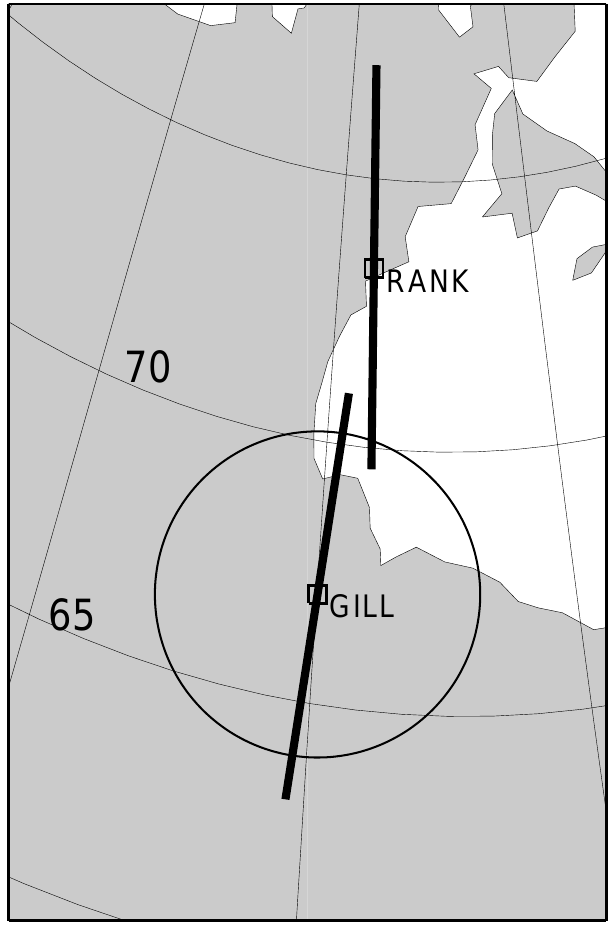
Fig. 2. The ASI used in this study is located at Gillam, Manitoba (56 . 4 ◦ north, 265 . 4 ◦ east). The circle indicates the Gillam ASI FOV assuming an emission altitude of 110km. As well, we also show the FOVs of the Gillam and Rankin Inlet MSPs, again assuming an emission height of 110km. Contours of constant geomagnetic latitude (at 5 ◦ spacing) and longitude (at 15 ◦ or 1h magnetic local time spacing) are also